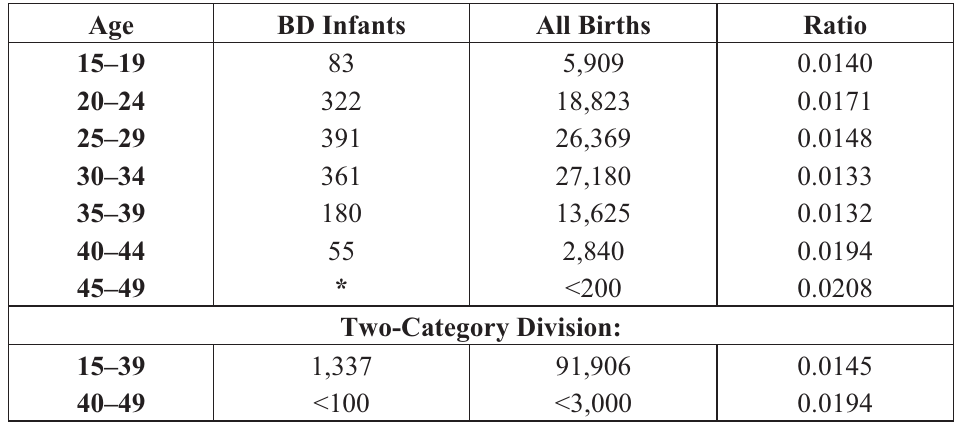
Table 1. Birth defect ratio by mother’s age category, New Hampshire,